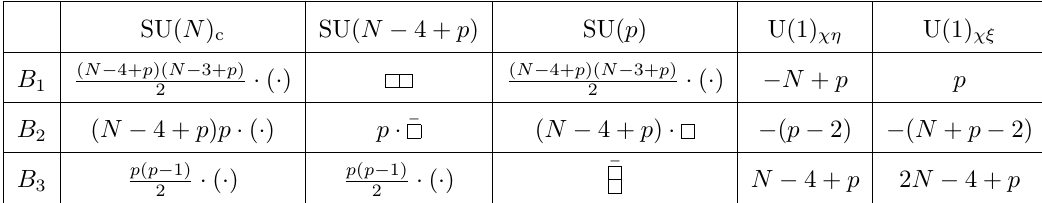
Table 10 . IR massless fermions in the chirally symmetric phase of the GG model.